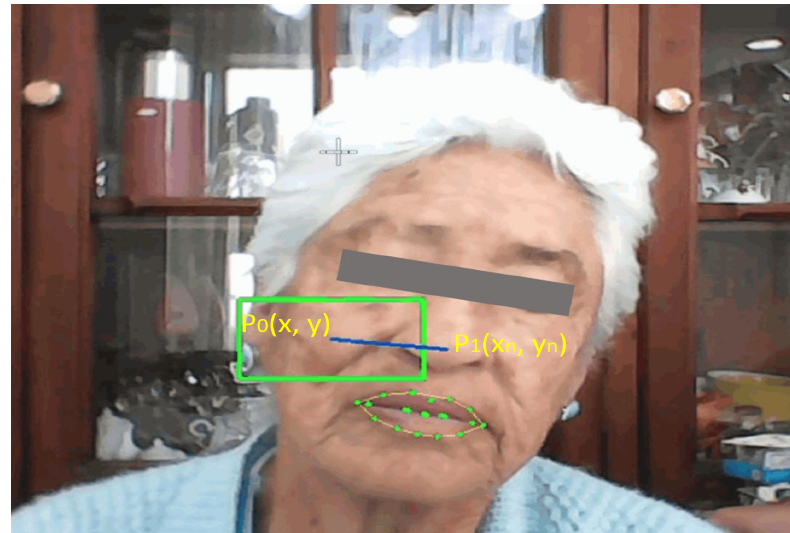
Figure 5. Face recognition when moving to the